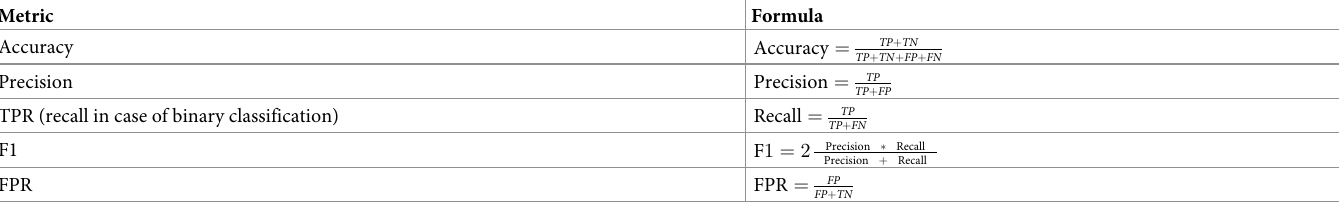
Table 3. Classification performance